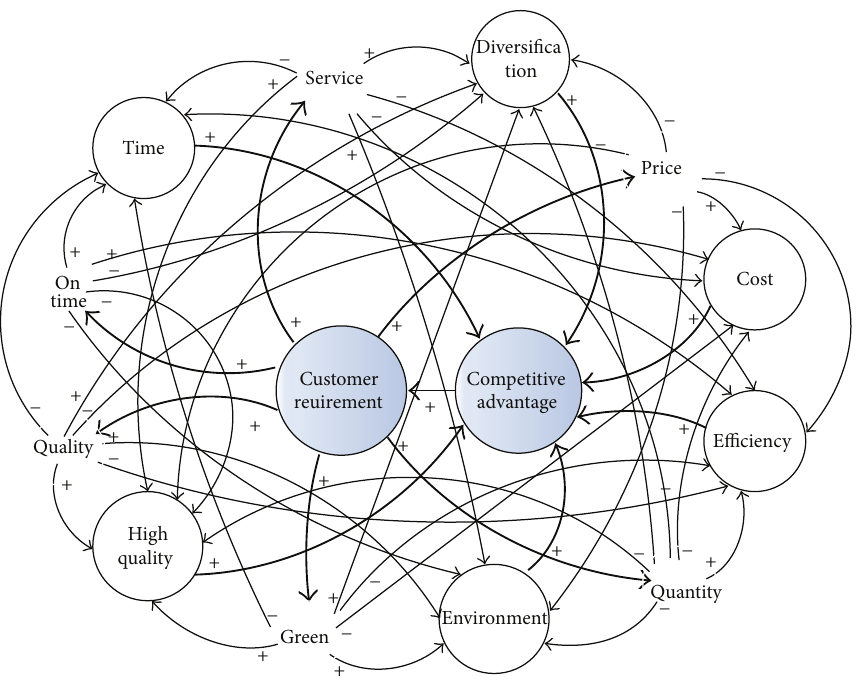
Figure 1: The function mechanism between the customer requirements and the system functional